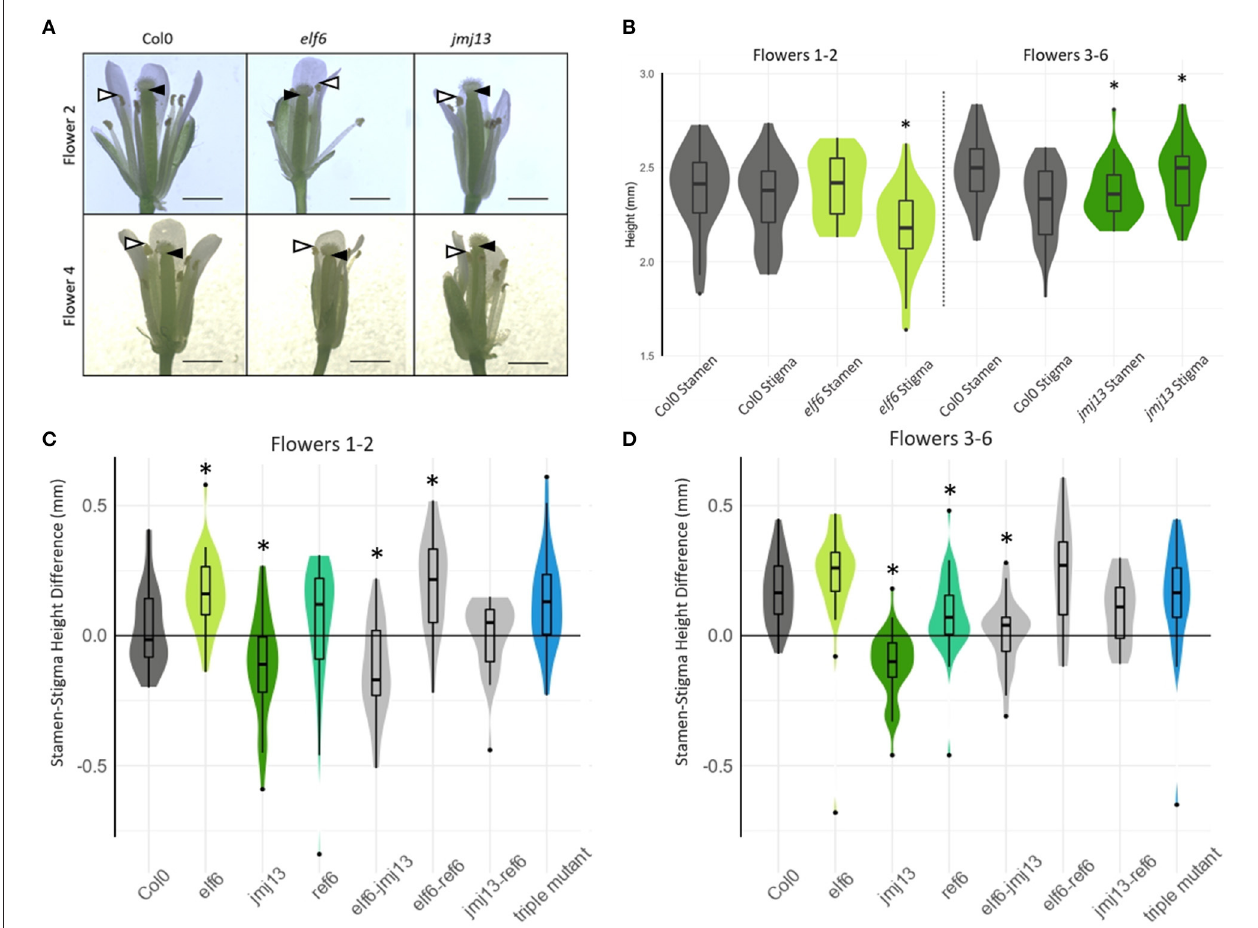
FIGURE 2 | Quantification of floral organ lengths in H3K27me3 knock-out mutants. (A) Representative images of stage 14 flowers of the indicated genotypes from flower positions 2 and 4 (scale bars represent 1mm). Black arrow heads indicate the lowest point of the stigma closest to the receptacle, whilst white arrow heads indicate highest point of the tallest stamen, the difference of which correlates with self-fertility. (B) The absolute heights of stamen and stigma from Col-0, elf6, and jmj13 flowers. Measurements were taken from receptacle to the top of the highest stamen and to the bottom of the stigma. n > = 20 for each genotype in each flower position. An asterisk indicates statistical significance compared to the respective Col-0 data of the same floral organ and flower position group ( p < = 0.05, t -test). (C) The lengths from receptacle to the tip of the tallest stamen, and receptacle to the lowest point of the stigma were measured. The difference between these two lengths is plotted for every flower measured at flower positions 1–2 and distributed by genotype. Groups marked with an asterisk are statistically significantly different from the Col-0 stamen/stigma height differences ( p < 0.05, t -test). The violin graph represents the density of data point distribution displayed symmetrically along the y axis. n > = 20 for each genotype. (D) Stamen-stigma height differences were measured and plotted as in (C) but for flower positions 3–6. n > = 20 for each genotype.